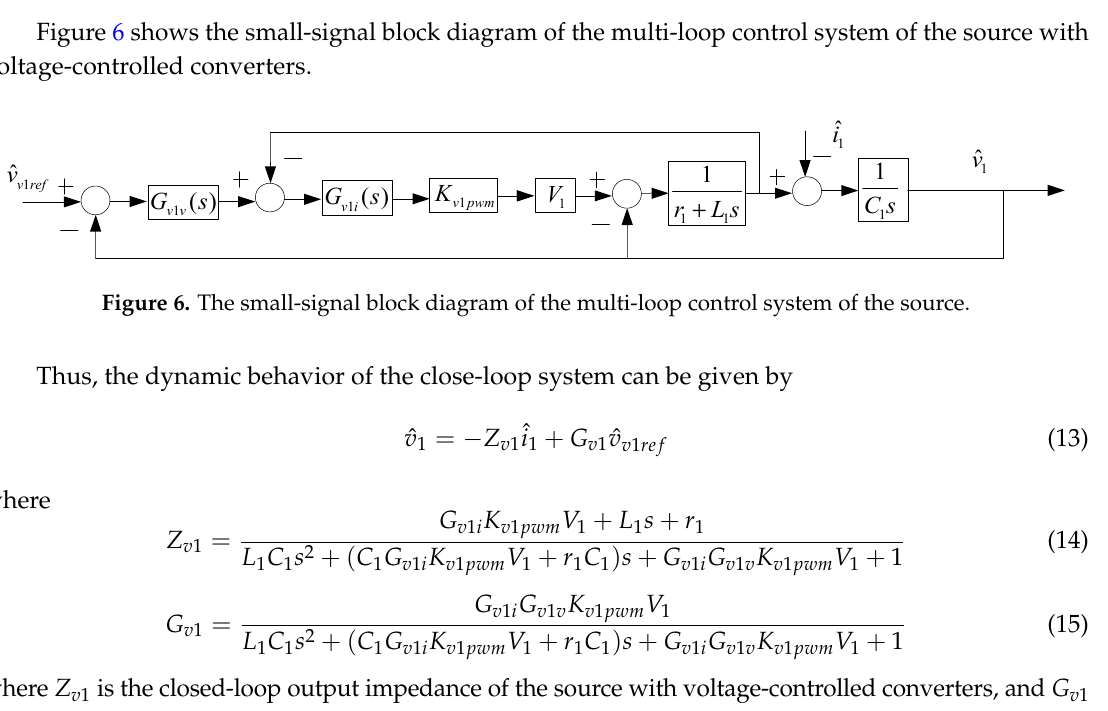
Figure 5. The close-loop circuit of the source with voltage-controlled converters (where G v 1 v and G v 1 i are the voltage and current controllers).